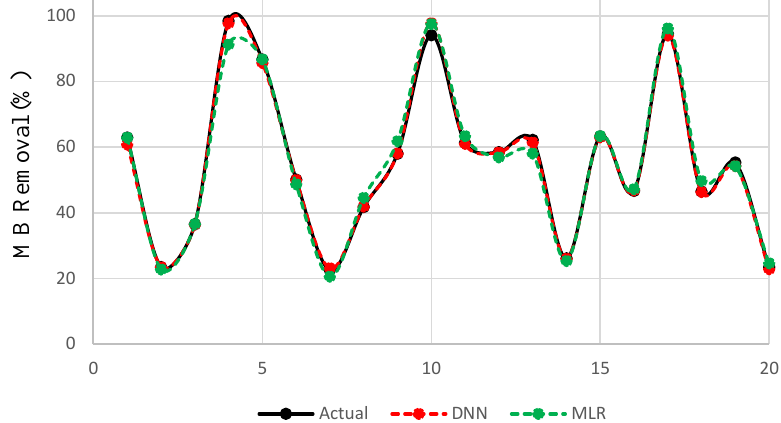
Figure 4. The predicted and actual values using DNN and MLR.